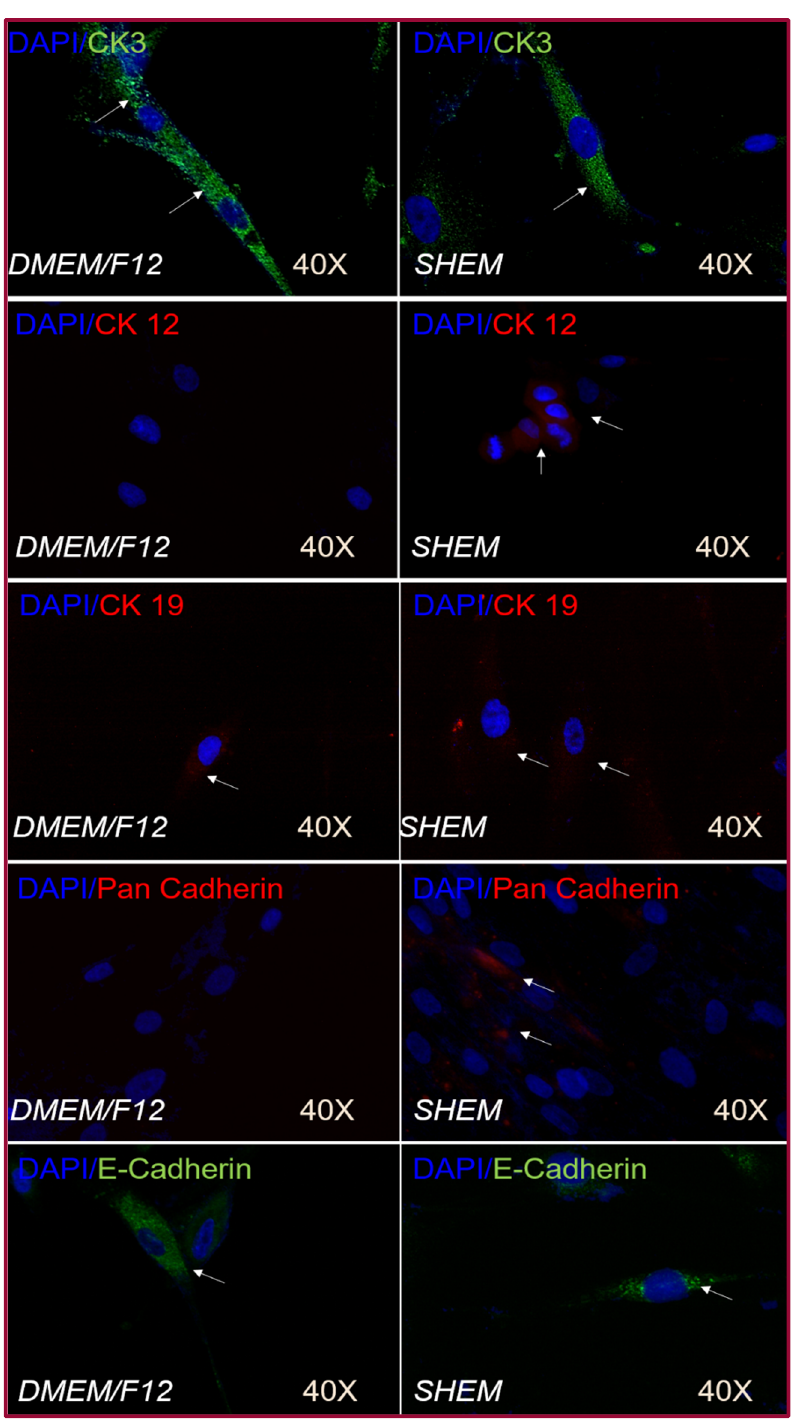
Figure 6. Epithelial markers—cell culture without AM. SHAM and DMEM/F12 groups presented intense positivity to CK3 in the cytoplasm (white arrows). The positivity to CK19 in both groups was low and localized in the cytoplasm (white arrows). E-cadherin was present in both groups, but the main difference was that DMEM/F12 medium showed diffuse cytoplasmic localization, but SHEM showed punctual localization in the cytoplasm (white arrows). hOMSCs cultured with SHEM expressed CK12 and Pan-cadherin (white arrows).